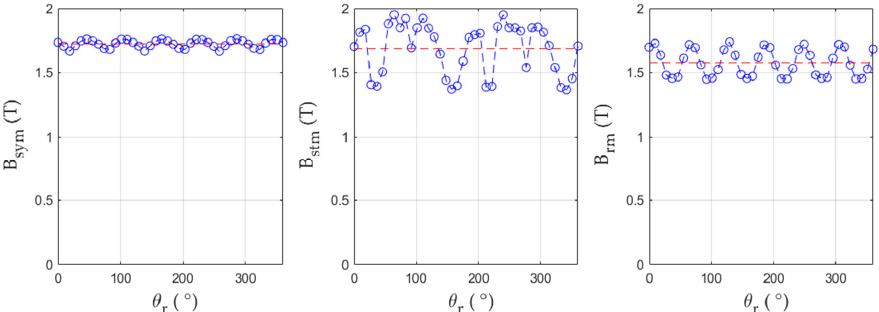
Figure 11. M270 ‐ 35 A Flux lines and flux density distribution at full load.